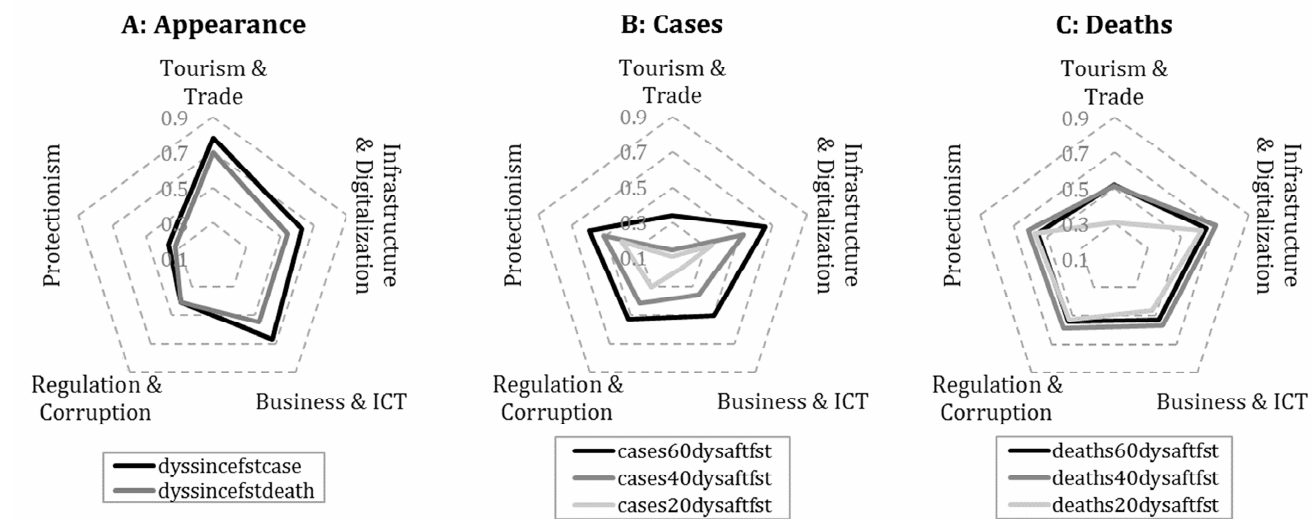
Figure 3. Absolute rank correlation between COVID-19 and latent variables. The correlations are presented according to the different COVID-19 variables related to the appearance of the virus ( A ), the number of cases ( B ), and the death toll ( C